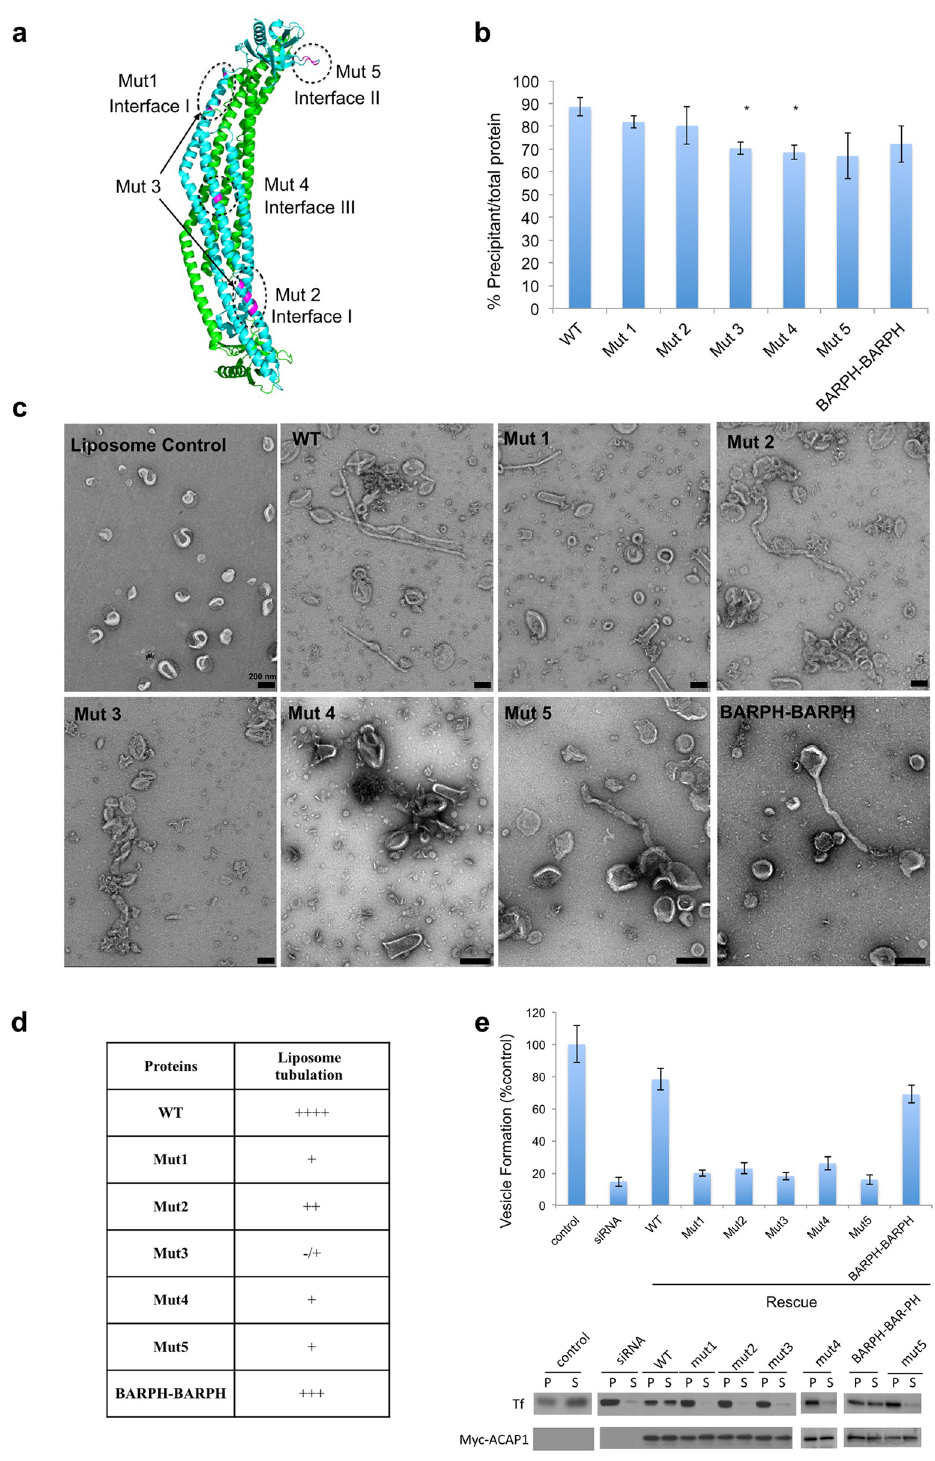
Fig 3. Mutagenesis studies to assess membrane binding and tabulation in vitro and endocytic recycling in vivo . ( a ) Location of mutations indicated on the structure of ACAP1 BAR-PH (PDB: 4NSW) are coloured in magenta. Interfaces implicated in higher-order assembly of ACAP1 BAR-PH are circled with dotted lines. Mutations are indicated: Mut 1, R236A/E239A/K248A; Mut 2, R118A/E122A/R125A/D126A; Mut 3, a compound mutation of Mut 1 and 2, R118A/ E122A/R125A/D126A/R236A/E239A/K248A; Mut 4, D92A/R236A; Mut 5, BARPH-Deletion,